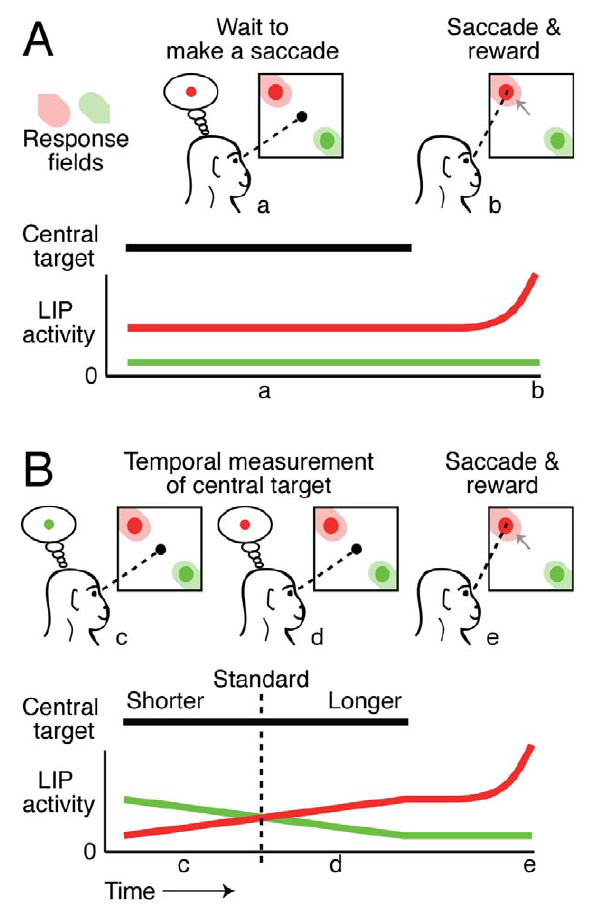
Figure 1. LIP activity during saccade and temporal measure- ment tasks. (A) Typical delayed saccade task. A monkey is trained to fixate (a) on a central target (black) while two peripheral targets are presented (red and green circles). Before the trial starts, the animal is cued to make a saccade (gray arrow) to the red target when the central target is extinguished (b). During the delay period (a) LIP neurons with response fields overlapping the saccade target (red trace) have sustained activity levels that are higher than LIP neurons with response fields located elsewhere (green trace). In addition, LIP neurons show an increased level of activity just before the saccade is made into their response field and a reward is received (b). (B) Temporal measurement task of Leon and Shadlen, 2003. Monkeys were trained to report the duration of a central target compared to a standard duration (dashed vertical line) by either a saccade to the green target to indicate a duration shorter than the standard or a saccade to the red target to indicate a longer duration. At the start of each trial, while the duration of the central target was still shorter than that of the standard, LIP responses preferentially reflected the location of the green target (c). As the trial progressed, however, the duration of the central target eventually exceeded the standard, and the monkeys’ impending saccade was now directed to the red target (d). The activity of an LIP neuron with a response field corresponding to the short target (green trace) initially exhibited higher activity than a similar LIP neuron corresponding to the long target (red trace). As the trial progressed the activity levels of these two neurons reversed in a way that followed the monkey’s judgment of the duration of the central target. An increase in LIP activity also occurred in this task just before the saccade (e).